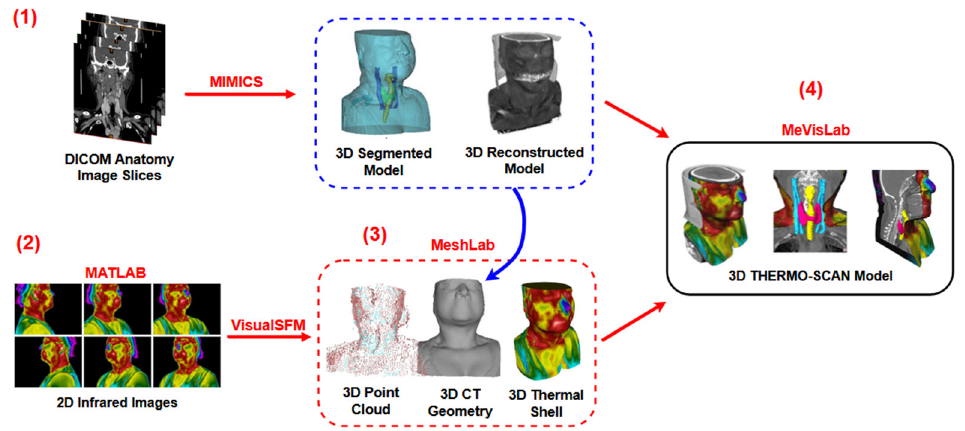
Figure 1. Schematic diagram of the proposed method.